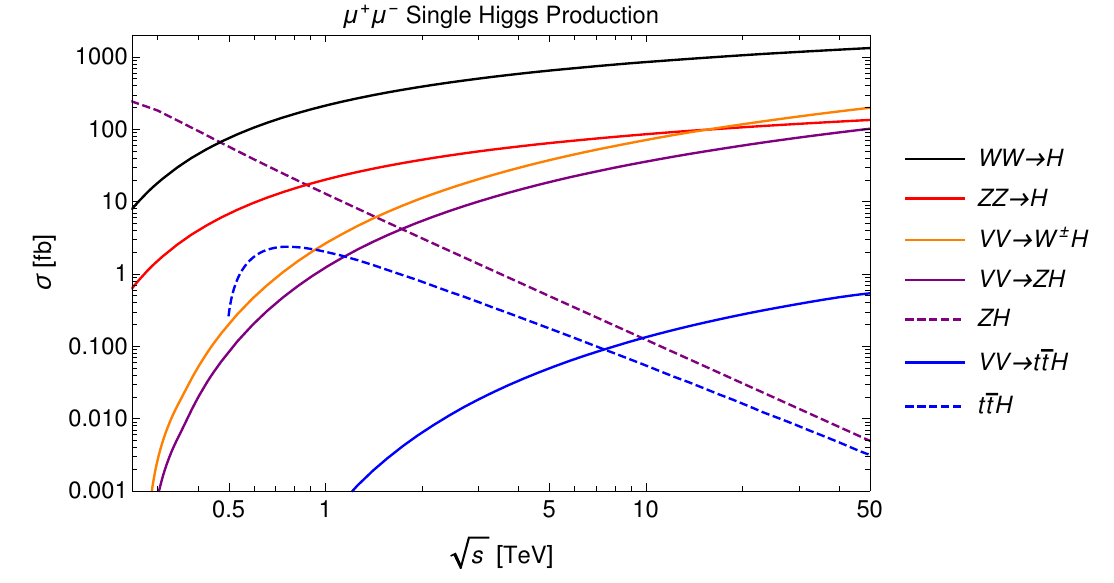
Figure 1 . Cross sections for the most important single Higgs production modes as a function of energy. Here ZH and t ¯ tH are s -channel production while the others are vector boson fusion produced in association with any of ( ν